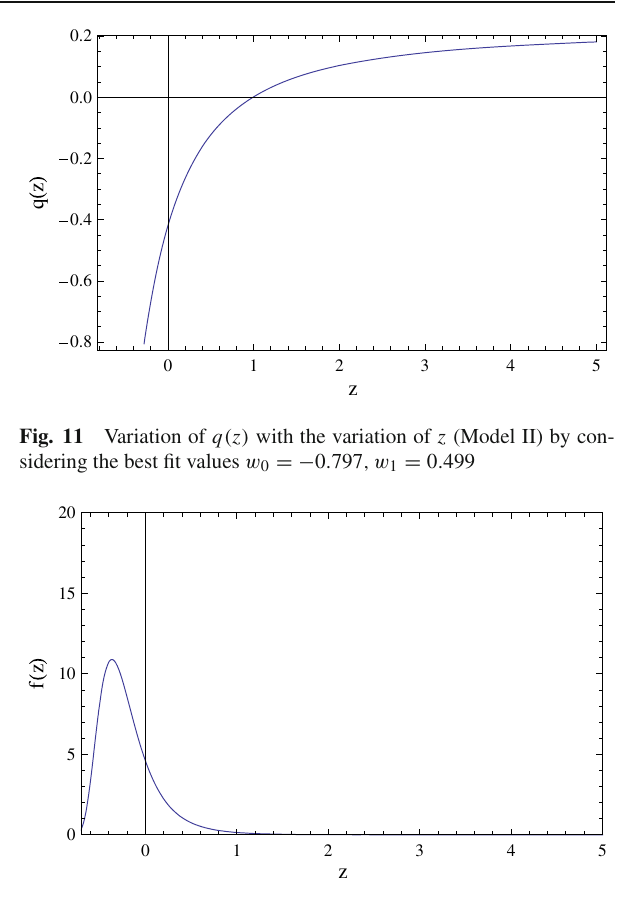
Fig. 12 Variation of f ( z ) with the variation of z (Model II) by consid- ering the best fit values w 0 = − 0 . 797 ,w 1 = 0 .